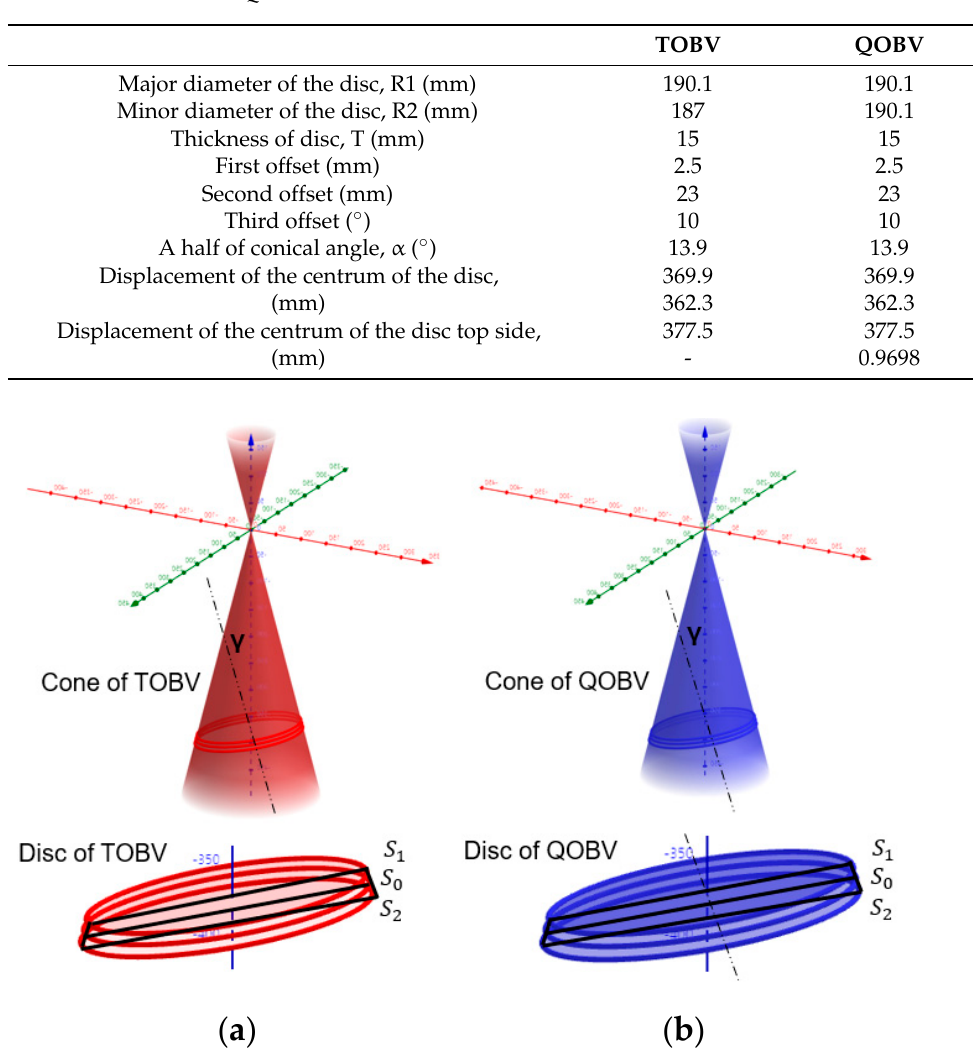
Table 1. Dimensions of QOBV and TOBV.